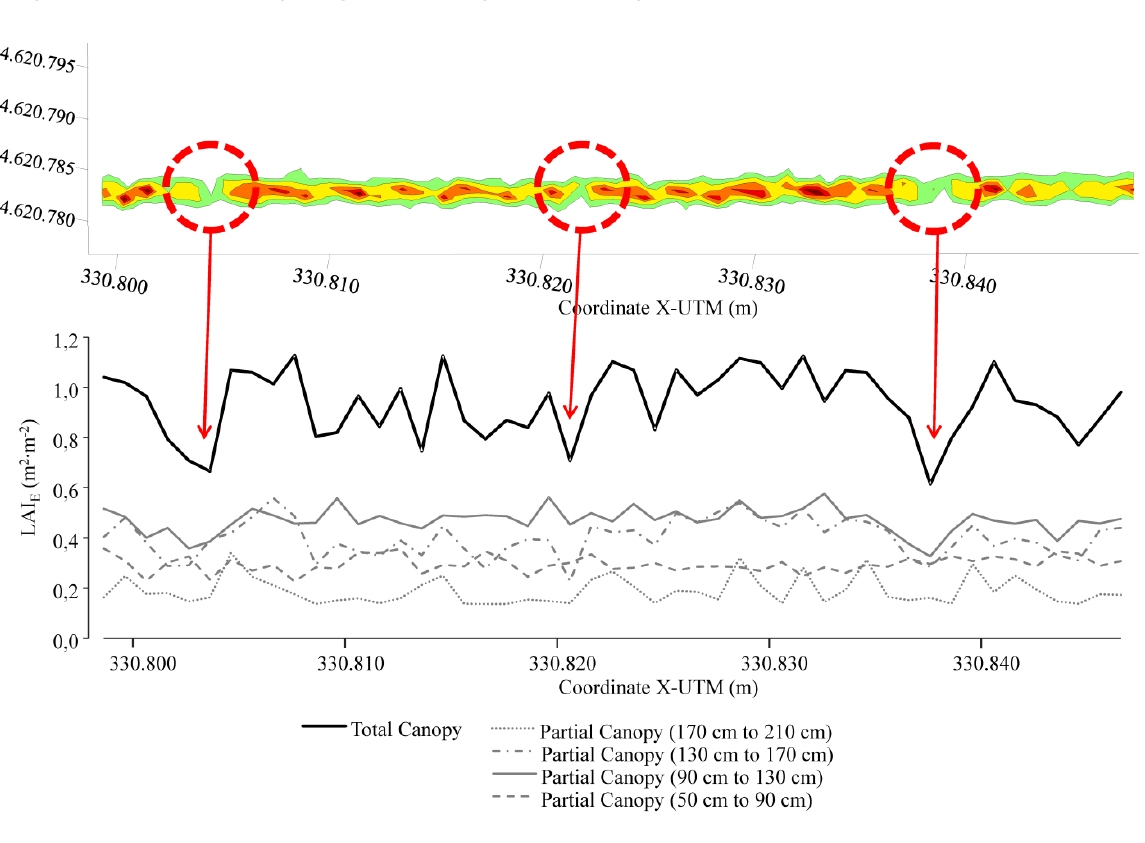
Figure 14. Evolution of LAI estimated values along the row crop obtained after density LiDAR returns classified on a 1.0 m length grid. Values have been obtained for the whole vegetation and for every single crop height previously defined (row 70 var . Merlot